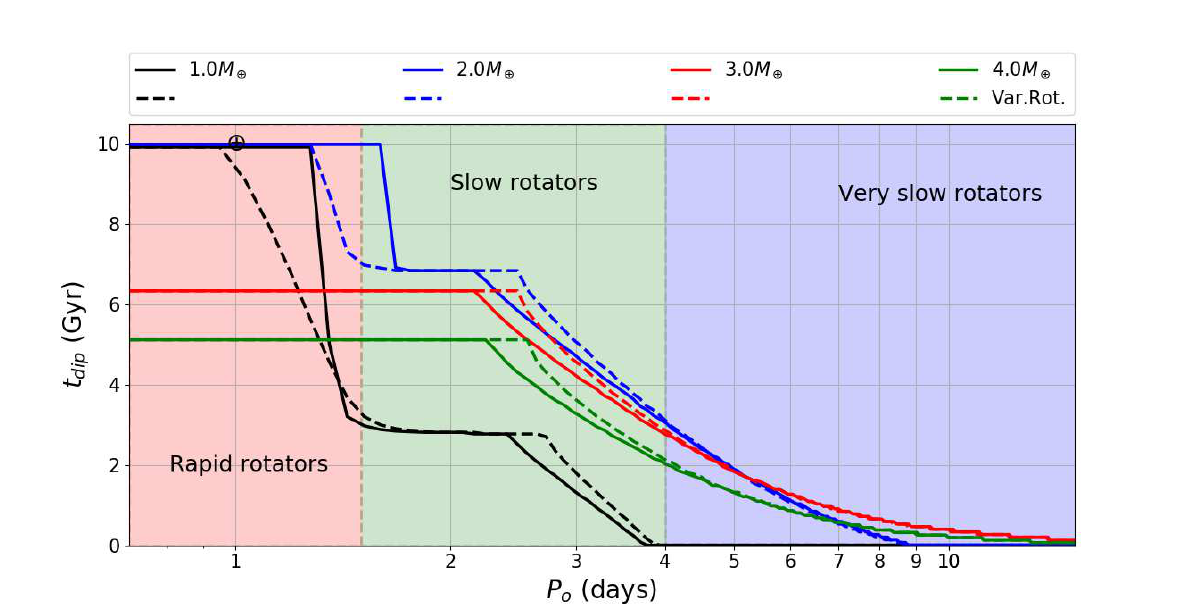
evolution for planets with different masses. l